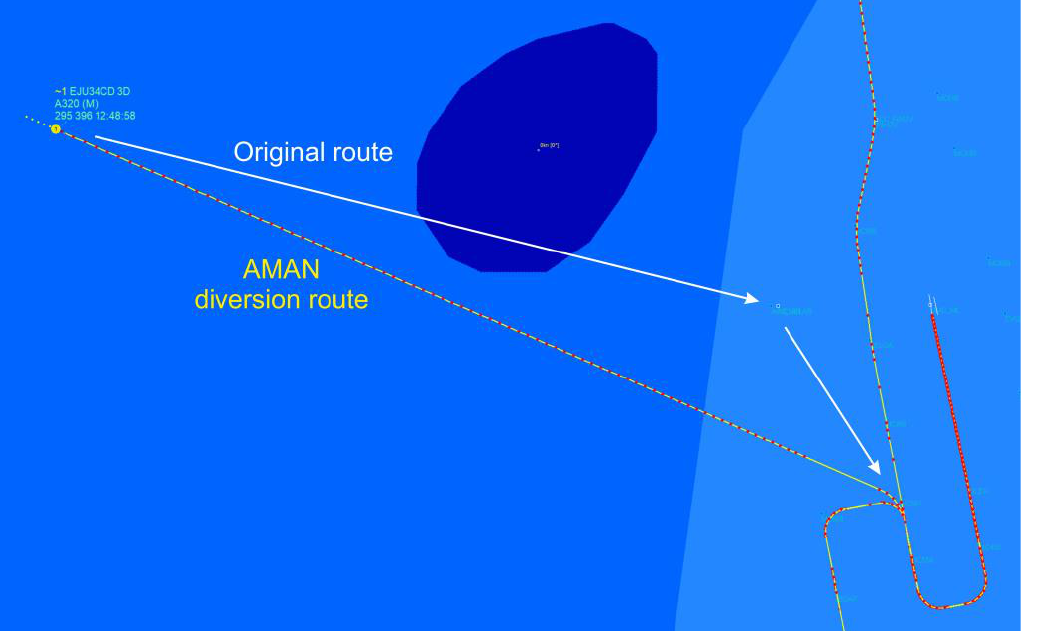
Figure 17. A large-scale diversion route plan for aircraft EJU34CD, currently No. 1 in the arrival sequence and approaching MXP from the west. The white arrows indicate the original STAR and the yellow–red dotted line represents the AMAN 4D trajectory. MXP traffic mix from 11 May 2019 with weather from 11 May 2019 and the WRF-RUC nowcast model.